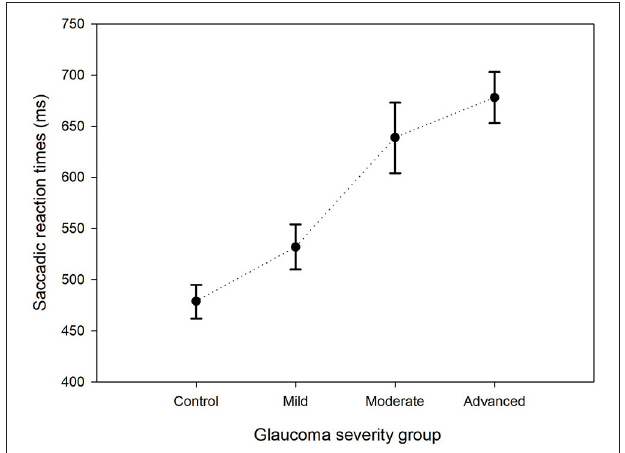
FIGURE 2 | Estimated mean saccadic reaction times per group. The estimated mean SRTs and their corresponding 95% confidence intervals for the control group and the three glaucoma groups are shown.